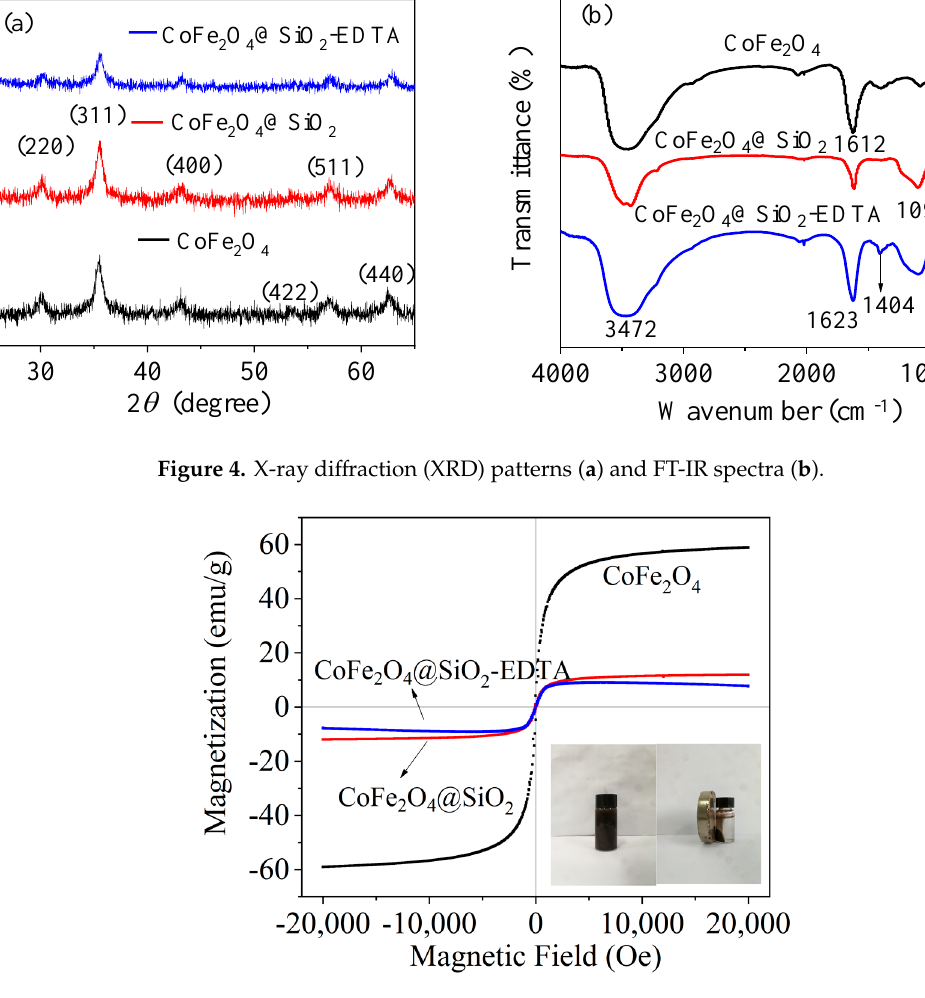
Figure 5. Vibrating sample magnetometer ( VSM) of CoFe 2 O 4 , CoFe 2 O 4 @SiO 2 and CoFe 2 O 4 @SiO 2 - EDTA.